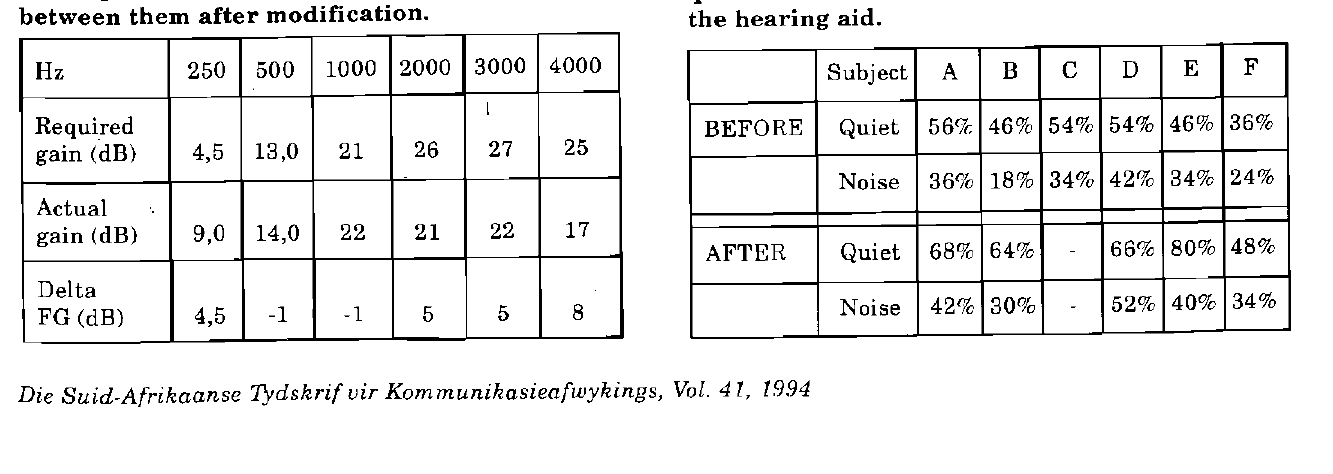
Table 5. Aided speech discrimination scores